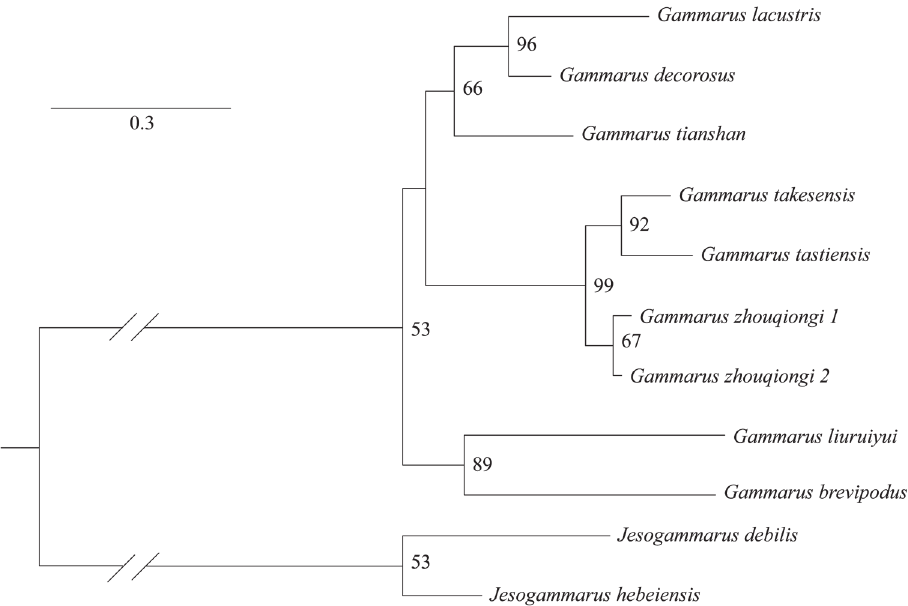
Figure 3. Maximum likelihood tree for Gammarus from Xinjiang based on combined markers (CO1+16S+28S+EF1 α ). Numbers near the nodes are bootstrap values.